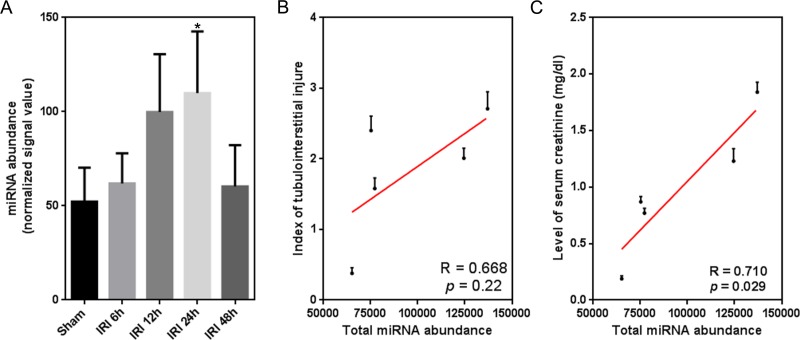
Temporal correlation between the expression of global miRNAs and renal function indexes.(A) Temporal miRNA expression change within 48 h after renal IRI. miRNA abundance is defined as raw microarray signal output normalized to the blank value 0.1; ∗p < 0.05 versus sham (Kruskal-Wallis test). (B and C) Temporal correlation between total miRNA abundance and index of tubulointerstitial injury/level of serum creatinine (n = 8). Total miRNA abundance is the sum of the abundance values of all miRNAs detected by microarray.